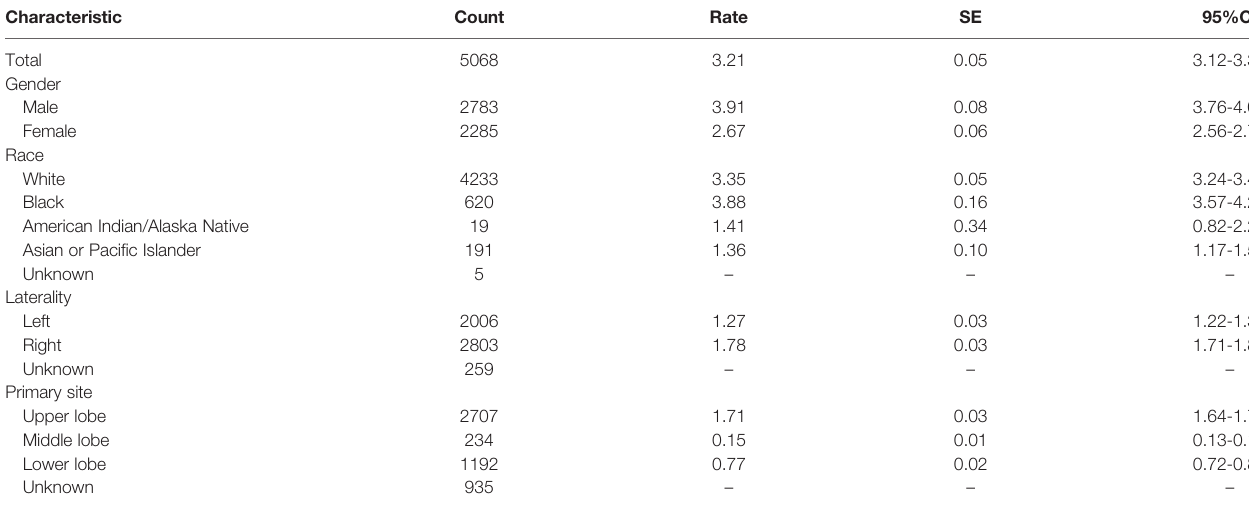
TABLE 2 | Population-based frequencies and age-adjusted incidence rates for patients with pulmonary large cell neuroendocrine carcinoma from the Incidence-SEER Research Data with 18 Registries (November 2019 Submitted) between 2001 and 2017. Characteristic